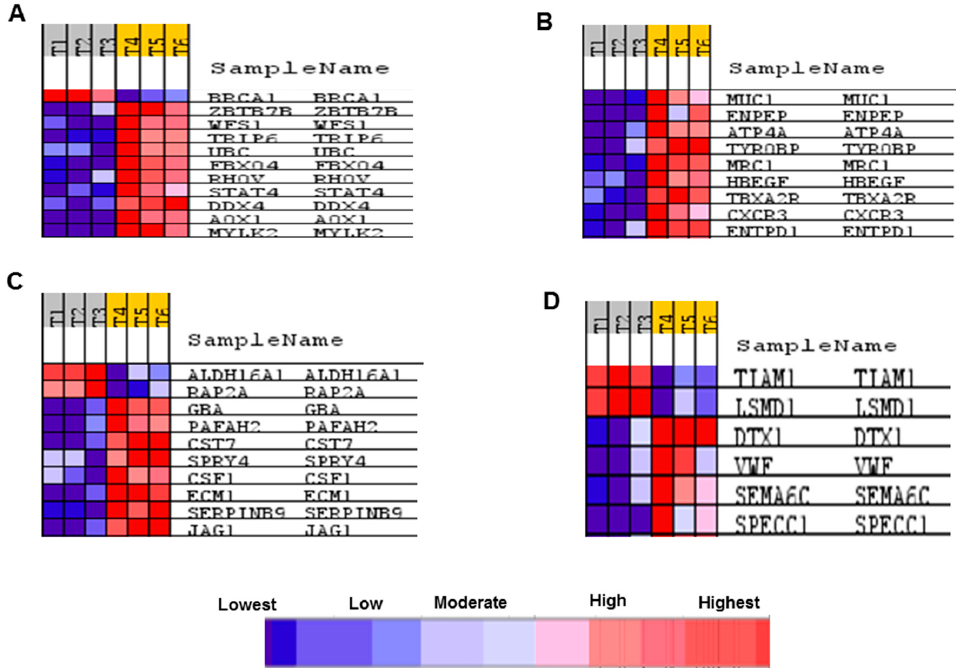
Figure 8. Identification of the genes that were affected by treating BS-24-1 cell with A. graveolens extract and also exhibited altered expression in human cancers. The GSEA software was used to identify genes depicted in expression heat maps that are enriched in various human diseases. ( A ) Breast cancer; ( B ) Leukemia; ( C ) Prostate cancer; ( D ) Notch pathway. T1–T3 represents samples of BS-24-1 cells treated with DMSO while T4–T6 represents BS-24-1 cells treated with A. graveolens extract. Blue and red colors represent relative levels of expression according to the scale on the